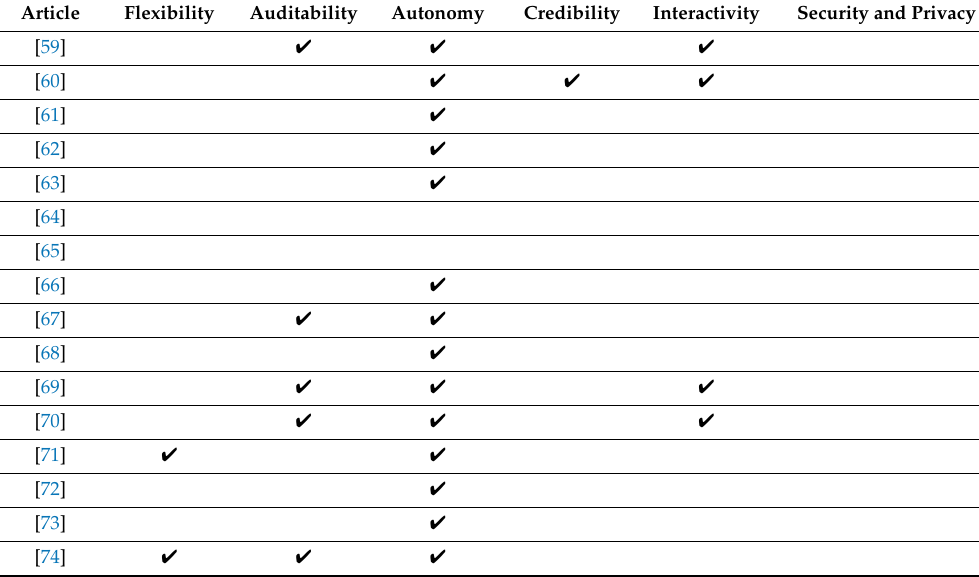
Table 7. Sports articles.